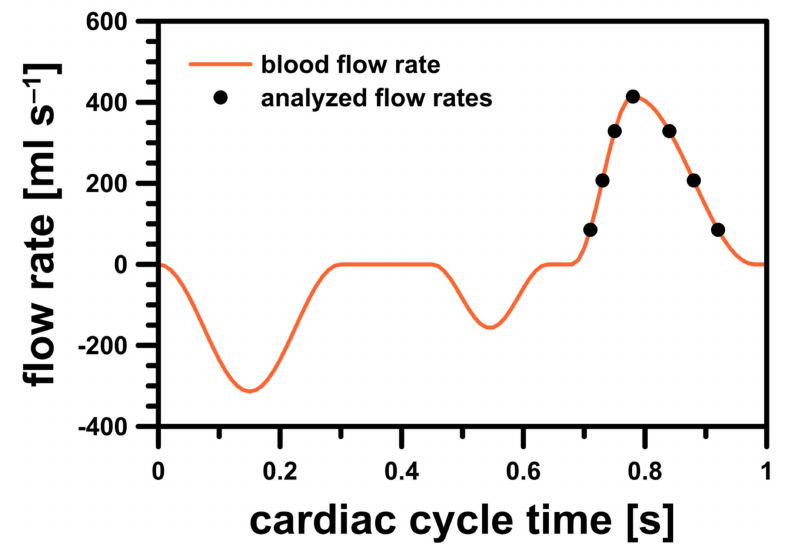
Figure 3. Blood flow rate profile for LV